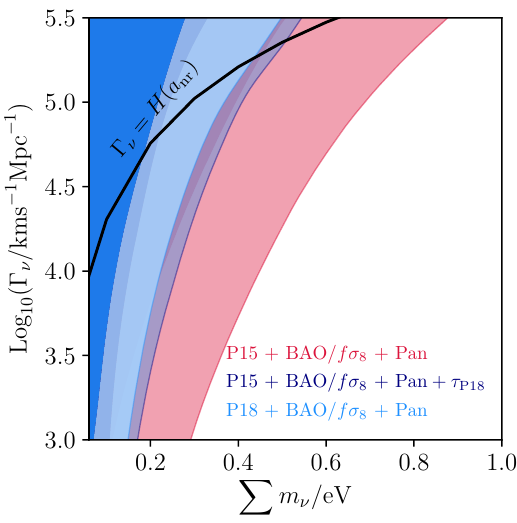
(Γ [km / s / Mpc]) with Planck 2018 and Planck ν / 10 from Planck 2018. The agreement of the posteriors shows the dominant reio and Log (Γ [km / s / Mpc]) comes from a precise measurement of τ ν ν / 10